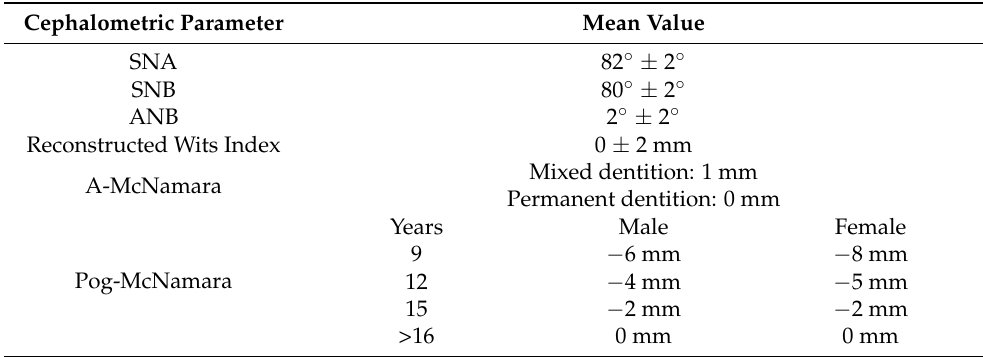
Table 1. Mean value and confidence interval of the cephalometric parameters. Cephalometric